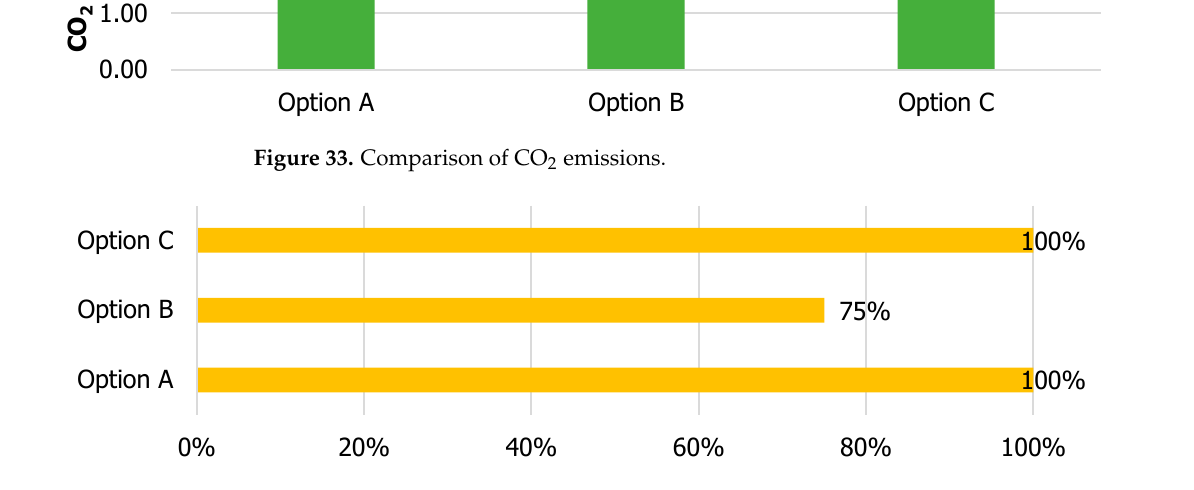
Figure 34. Percentage of CO 2 emissions released.